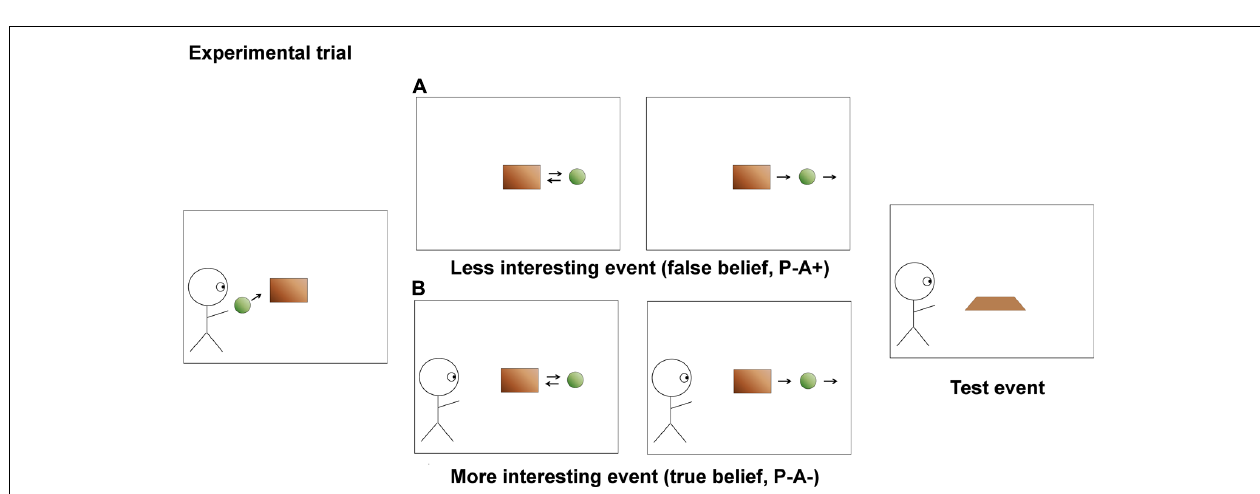
FIGURE 2 |The two experimental conditions from Kovács etal. (2010; experiment 5). In condition (A) the agent’s and the infant’s beliefs differ, but this also renders the depicted event less interesting to the infant, compared to condition (B) . When the occluder is lowered in the last